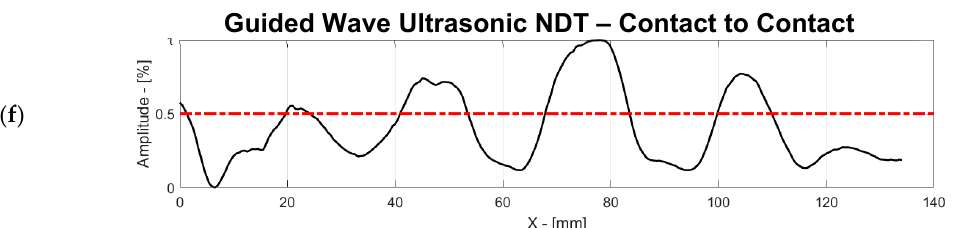
Figure 20. Decibel drop method ( − 6 dB and − 12 dB) to measure the defect size for different ultrasonic NDT techniques: ( a ) immersion ultrasonic through-transmission; ( b ) immersion ultrasonic pulse-echo; ( c ) scanning acoustic microscopy; ( d ) air coupled ultrasonic testing through-transmission; ( e ) guided wave ultrasonic testing with air-coupled to contact; ( f ) guided wave ultrasonic testing with the contact-to-contact method. Table 3. The measured defect dimensions and relative errors for different ultrasonic NDT techniques over five debonding defects.